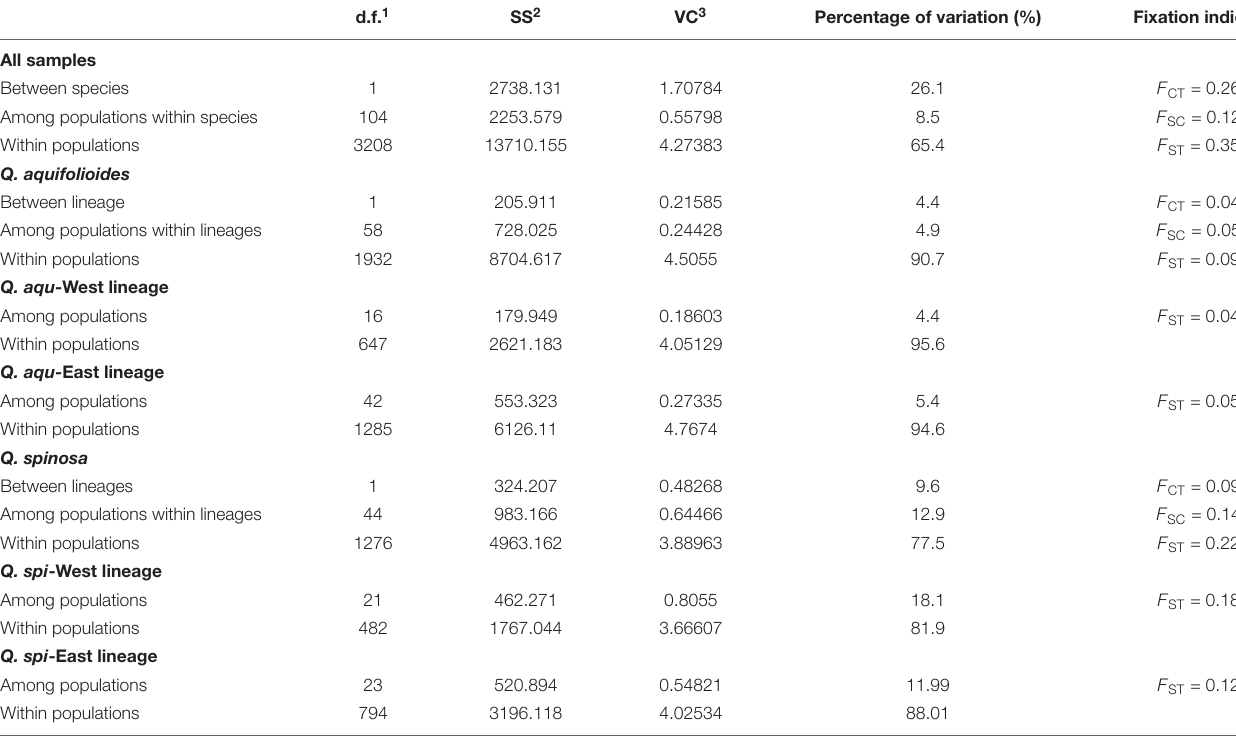
TABLE 2 | Hierarchical analyses of molecular variance (AMOVA) of Q. aquifolioides and Q. spinosa populations.